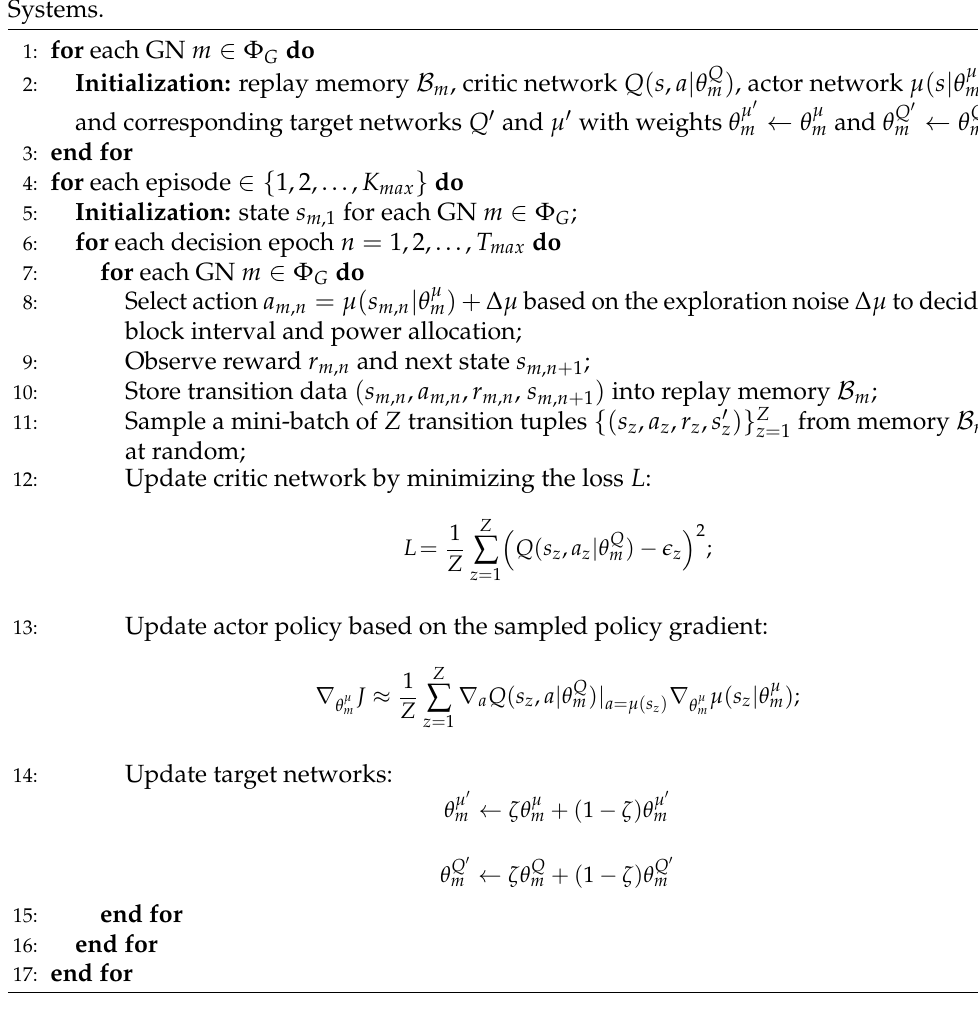
Algorithm 1 DDPG-based Optimization Framework for MEC-enabled Blockchain IoT